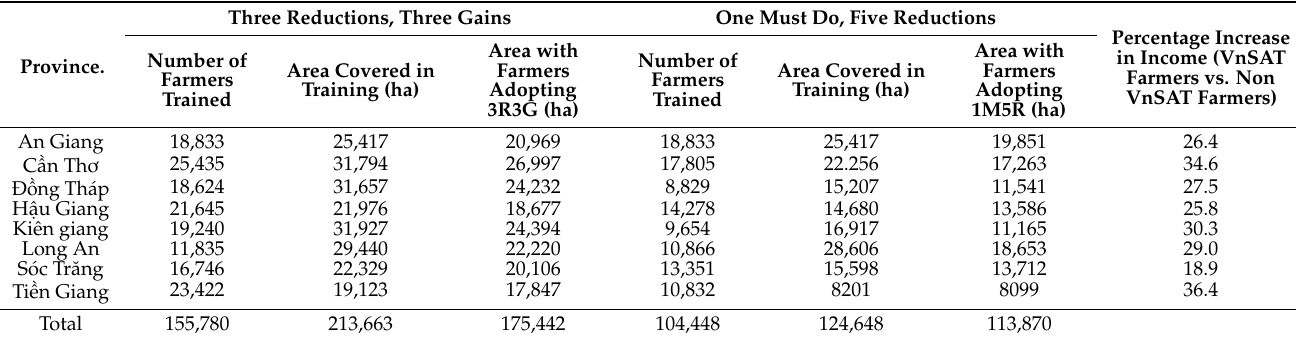
Table 2. Number of farmers trained, area covered, and area of adoption of Three Reductions, 3 Gains (3R3G) and 1 Must Do, 5 Reductions (1M5R), with percentage of increase in income comparing farmers within the Vietnam Sustainable Agricultural Transformation project (VnSAT) and those not in the program (non